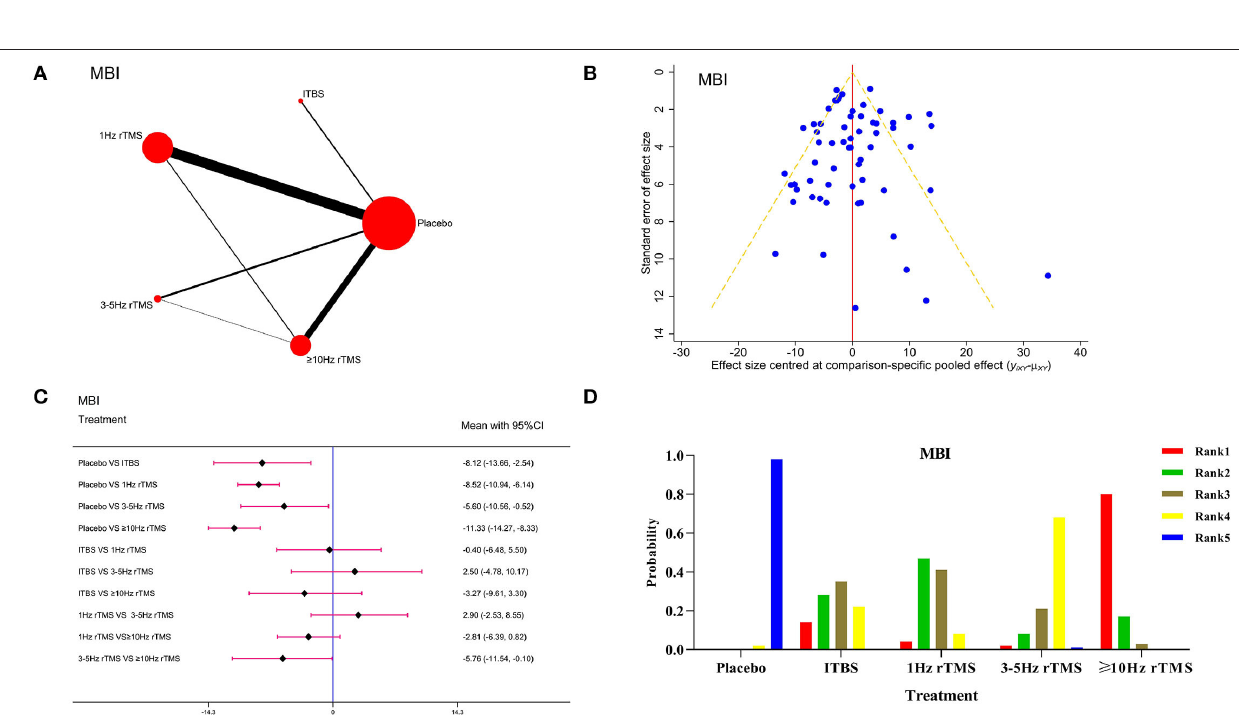
Frontiers in Neurology |